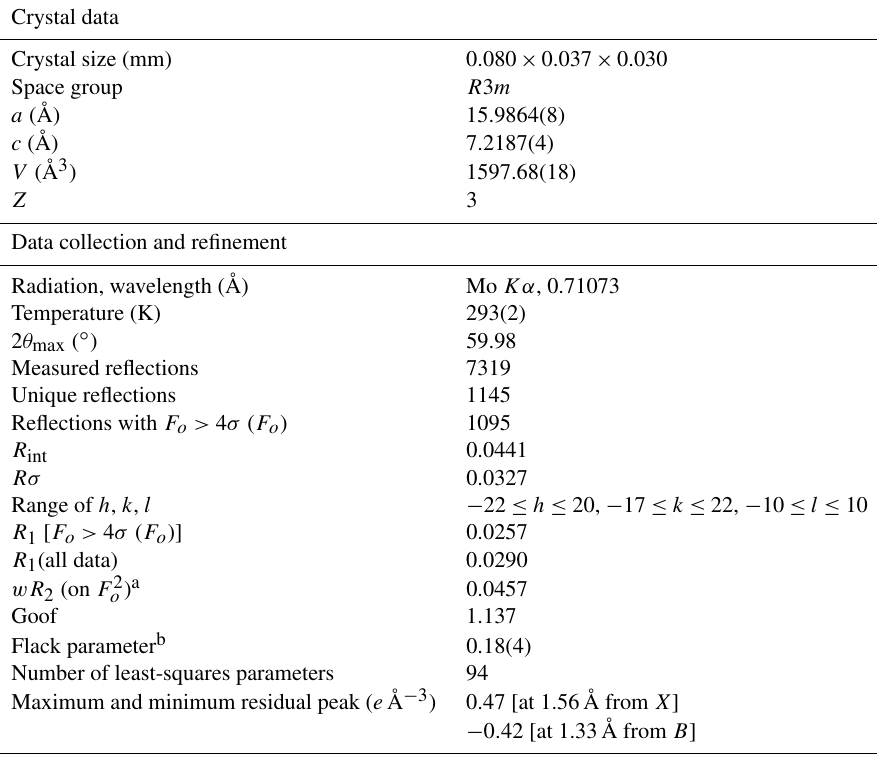
Table 4. Summary of parameters describing data collection and refinement for dutrowite.